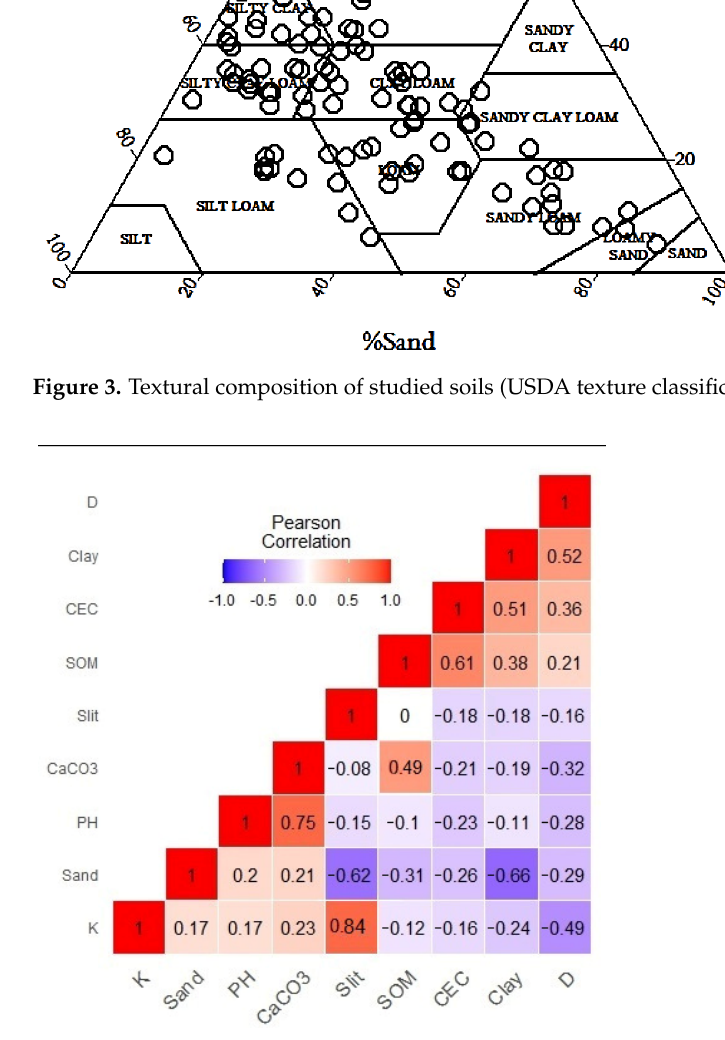
Figure 4. Pearson correlation coefficient (r) between D, K-factor, and soil properties.